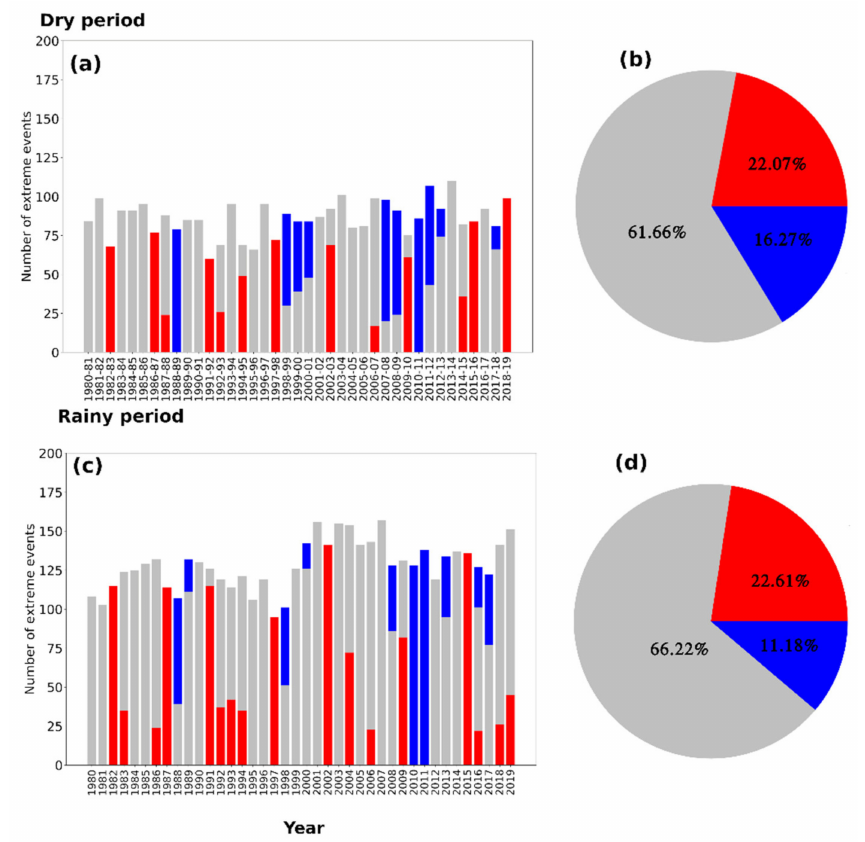
Figure 6. Left column: NEE during the different phases of ENSO: ( a ) Dry period and ( c ) rainy period. Right column: Percentage of NEE during each phase of ENSO: ( b ) Dry period and ( d ) rainy period. The colors represent the phases: red (El Niño), blue (La Niña), and gray (Neutral). Period is from 1980 to